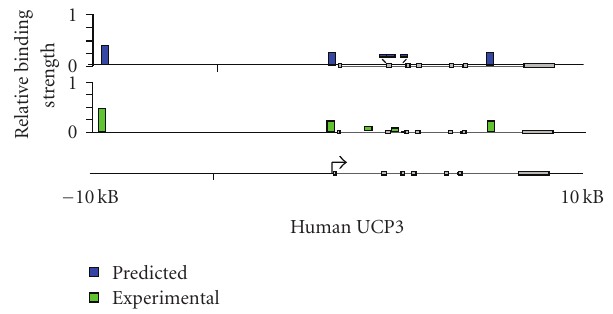
Figure 1: Comparison of in silico and experimental analysis of PPAR target genes. Overview of the genomic organization of the UCP3 gene; 10kB upstream and downstream of its TSS are shown (horizontal black line). Putative PPREs were identified using the classifier method performing in silico screening of the genomic sequences. For each predicted PPRE, the calculated binding strength of PPAR γ is represented by column height. The average in vitro DNA binding strength of PPAR γ -RXR heterodimers was also determined by gel shift